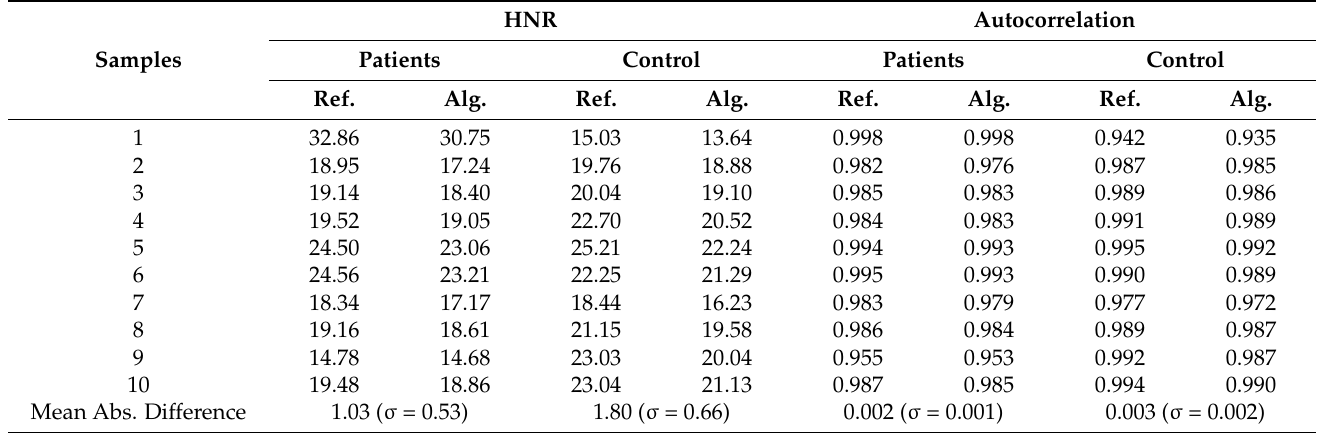
Table 6. Comparison of the values obtained by the algorithm with the reference software, for the parameters HNR and Autocorrelation, for the USP